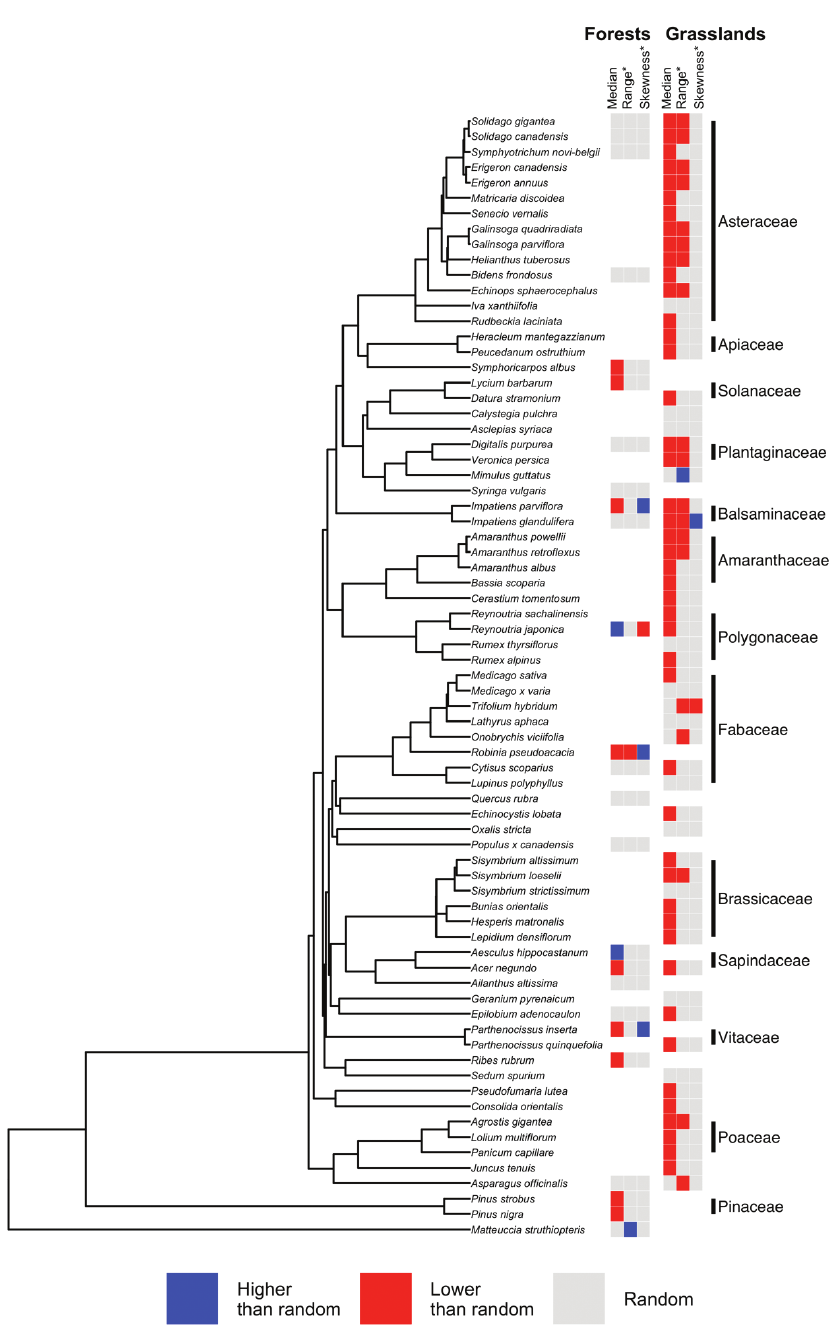
Figure 4. Phylogeny of naturalised neophytes found in vegetation plots. For each species, we show whether the median, range and skewness of S were higher (blue) or lower (red) than under random ex- c pectation or did not differ from the random expectation (grey) in forests and grasslands. The range and skewness of S were standardised as described in the Methods section. * = c